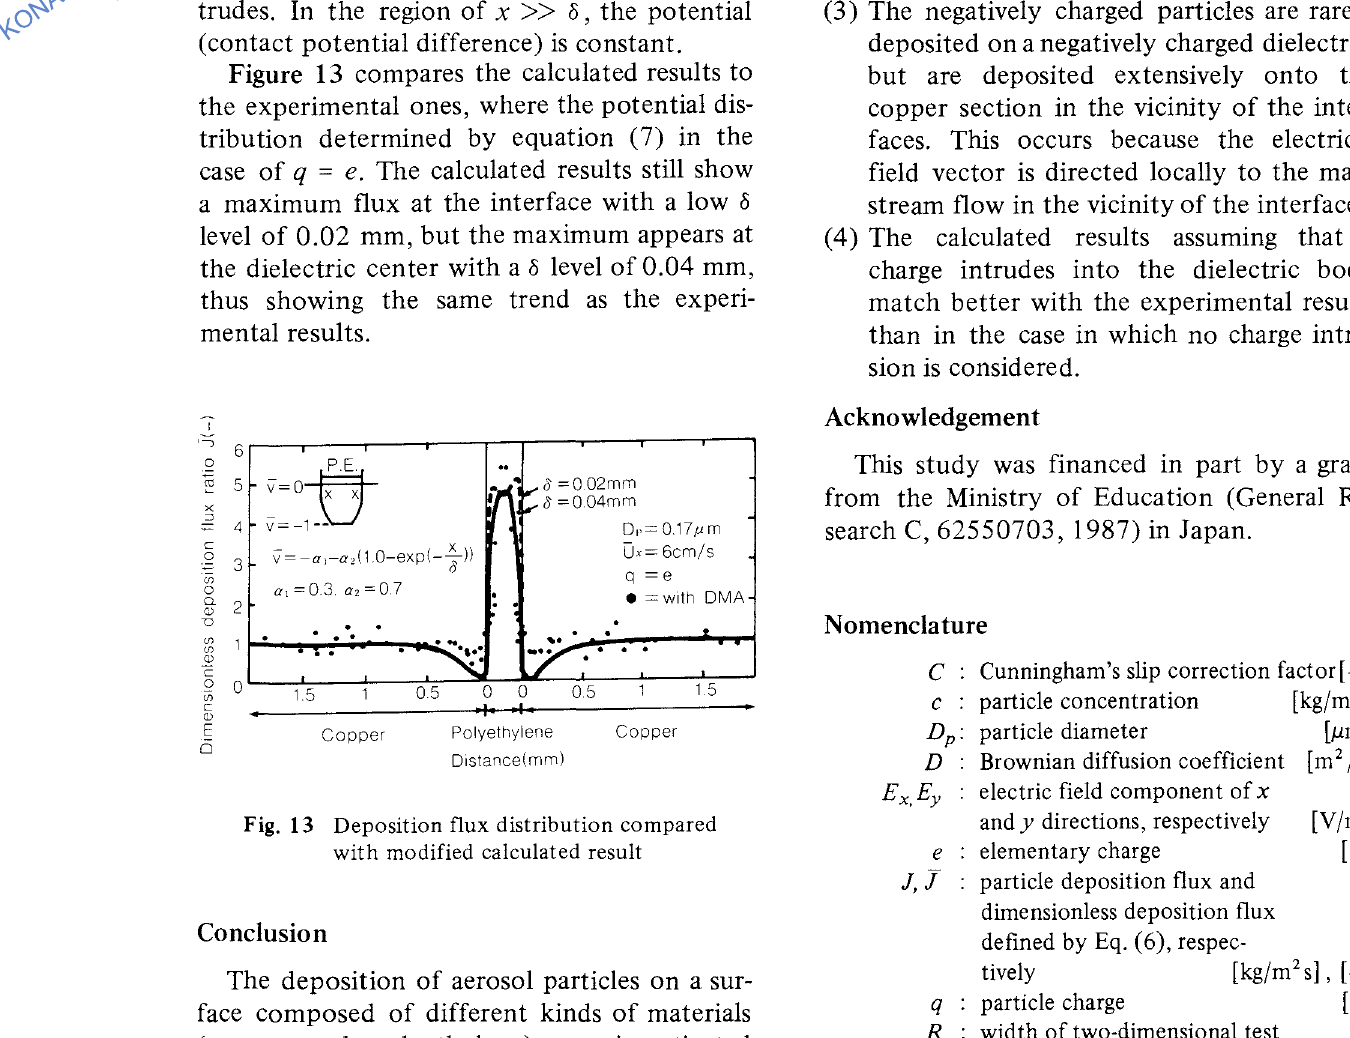
Fig. 13 Deposition flux distribution compared with modified calculated